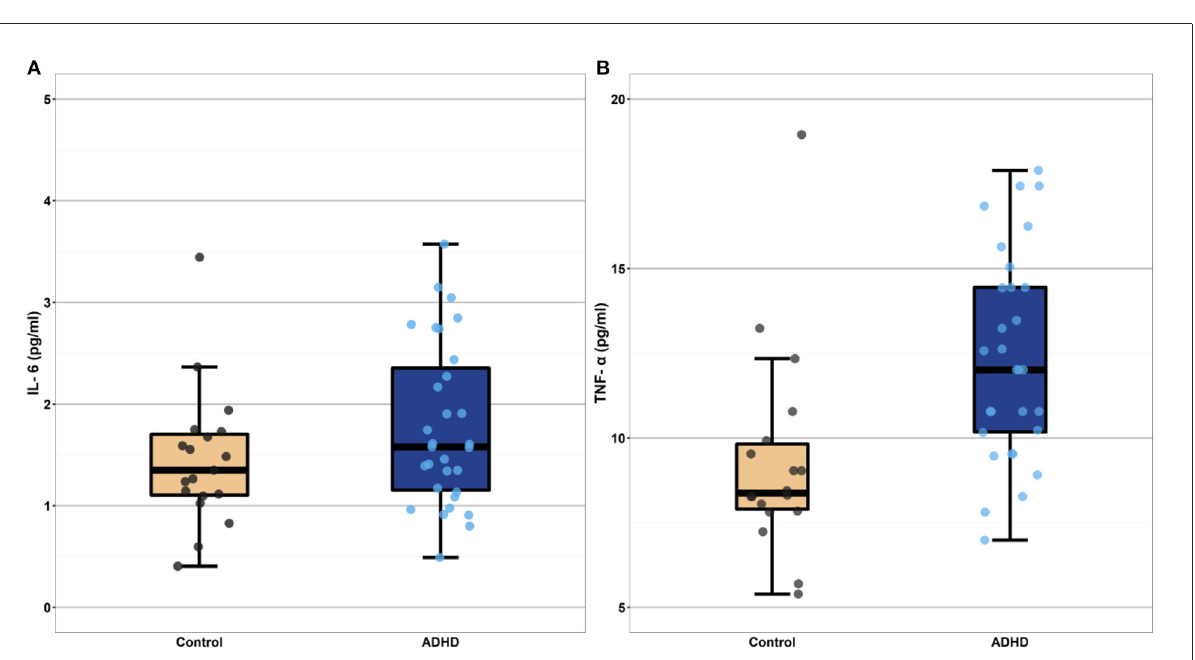
FIGURE1 Boxplots depicting mean level cytokine concentrations in the heightened ADHD symptoms and control groups (Panel A depicts IL-6 values and Panel B depicts TNF-a values). Cytokine concentrations depicted in these boxplots are raw values, selected for ease of interpretation. These raw values were log-transformed prior to all analyses. The heightened ADHD symptoms and control groups differed significantly in their mean TNF- α concentrations ( p < 0.001) even after controlling for participant pre-pregnancy BMI. Mean IL-6 concentration did not differ between the ADHD and control groups ( p = 0.83). IL-6, interleukin-6; TNF- α , tumor necrosis